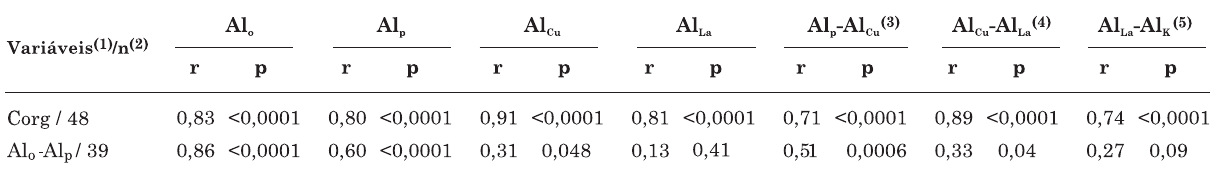
Figura 9. Relação entre (Al /Corg) x 100 e (a) Al p (b) Al -Al e (c) Al -Al . As frações de maior Cu La La K estabilidade da interação Corg-Metal (Al encontram-se a valores de (Al /Corg) x 100 acima p de 20, acentuando-se a valores acima de 40 (linhas